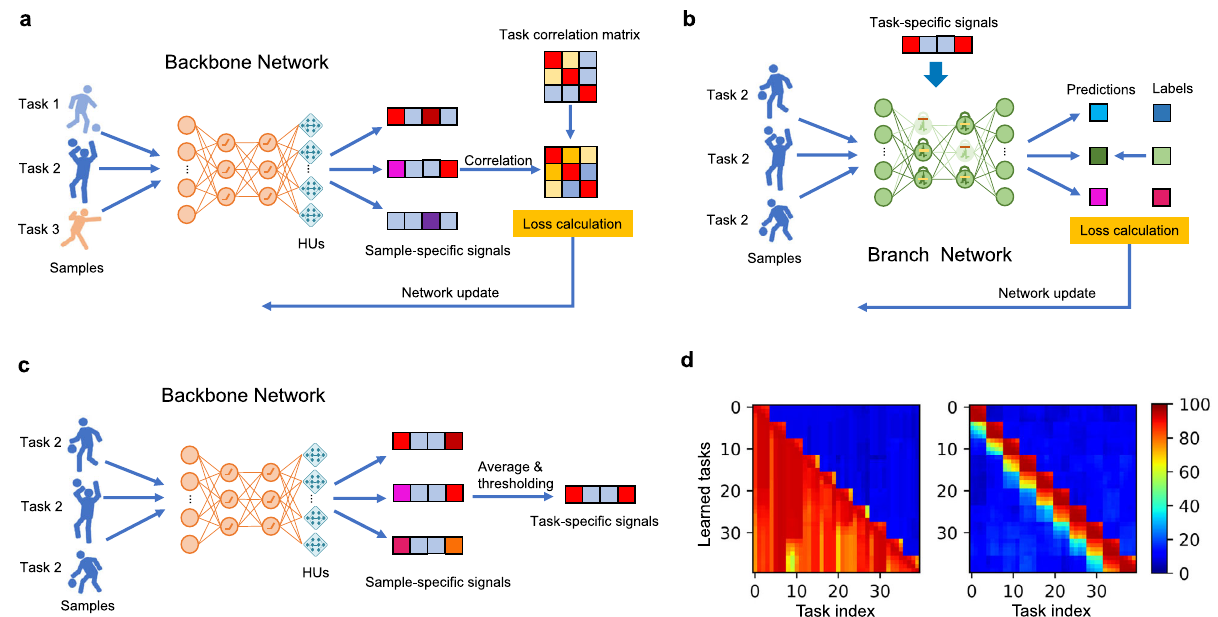
Fig. 5 The schematic of HMN. a The training framework of ANN-based backbone network. b The training framework of an SNN-based branch network for a speci fi c task. c The mechanism of generating task-speci fi c signals based on sample-speci fi c signals. d The comparison of test accuracy of HMN (left) and SNN (right) on individual tasks vs. the number of learned